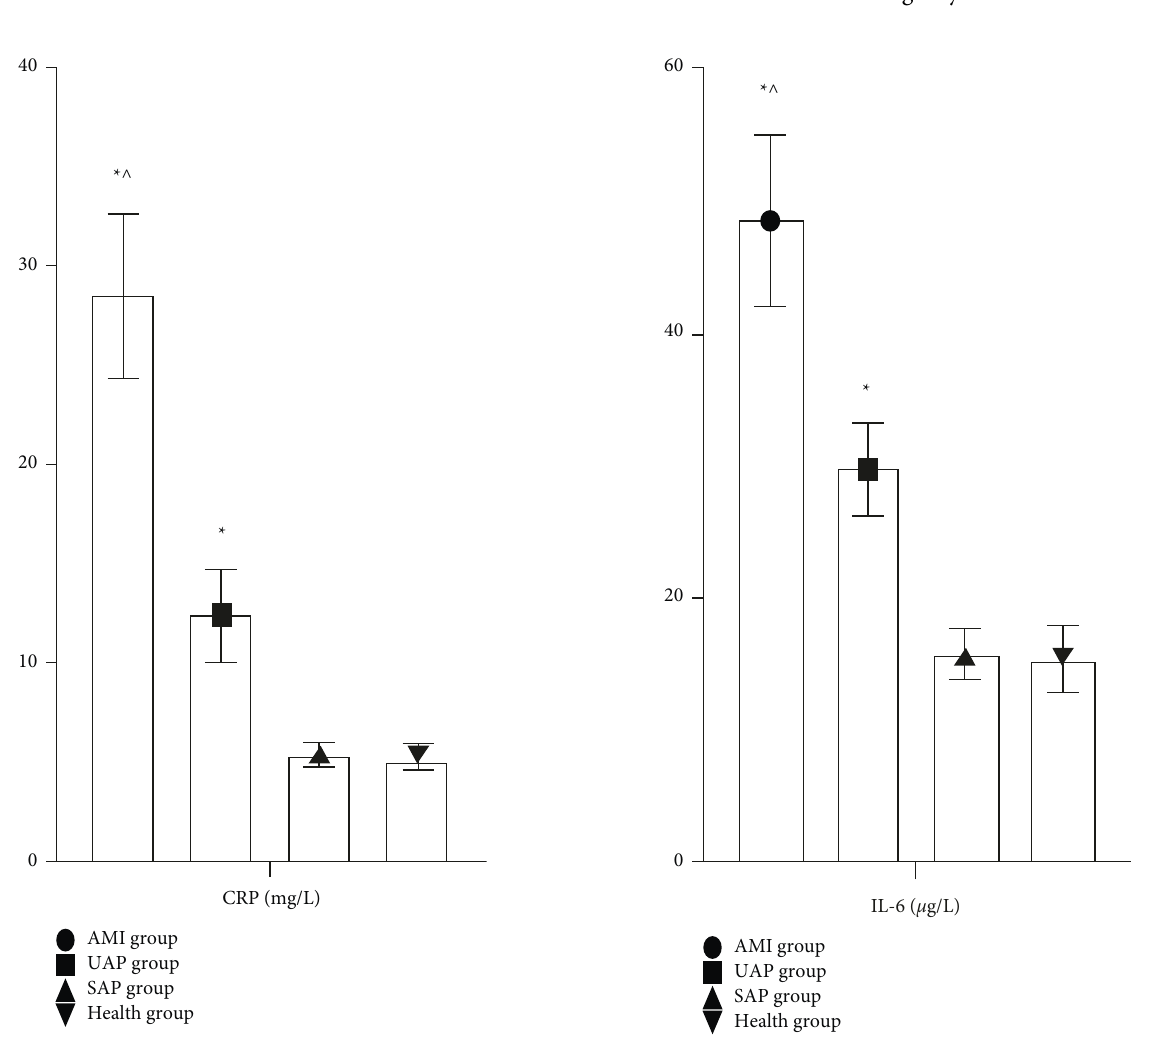
Figure 5: Serum CRP level (mg/L). Figure